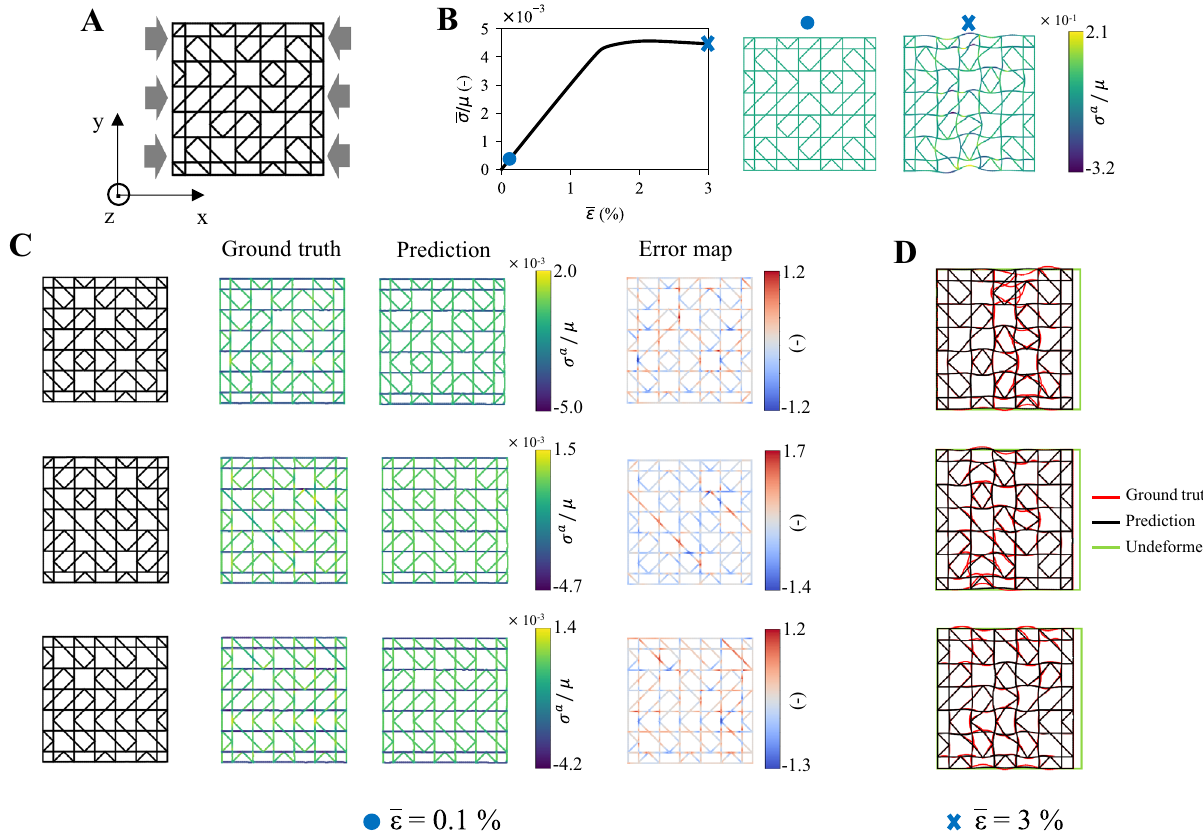
Figure 5. Predicting compressive behavior of lattice metamaterials. ( A ) Representative lattice structure under compressive loading. ( B ) Normalized effective stress-strain curve of the structure in ( A ) together with the normalized FE simulated stress field (i.e., axial stress, σ a , on the lattice’s beams) for small ( ε = 0.1% ) and large ( ε = 3% ) deformations. ( C ) Comparison of the ML predicted and FE simulated stress field for small deformations ( ε = 0.1% ) in three randomly chosen geometries from the test dataset, together with the corresponding error map. ( D ) ML predicted and FE simulated post-buckled deformed shapes for ε =3 % . The base material has incompressible nonlinear elasticity (hyperelasticity) with initial shear modulus µ = 14.5MPa